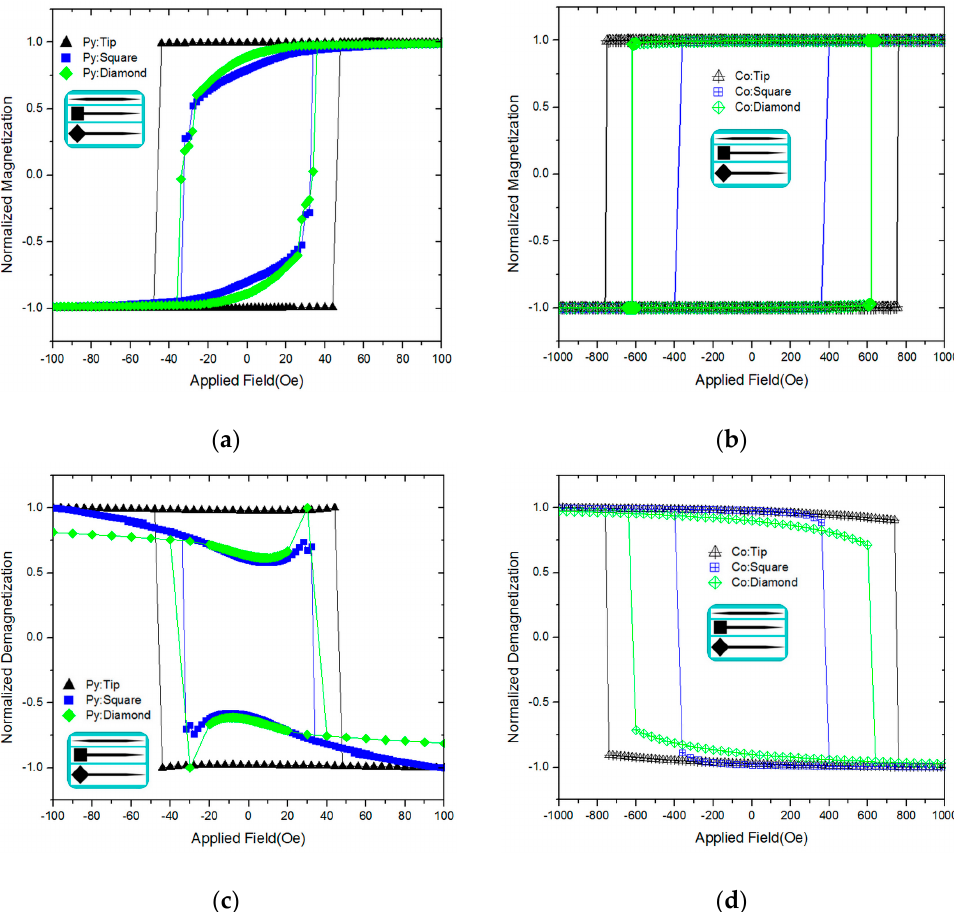
Figure 3. ( a ) The hysteresis loops of permalloy ( b ) the hysteresis loops of cobalt ( c ) the demagnetization loops of permalloy ( d ) the demagnetization loops of cobalt from the OOMMF micromagnetic simulations, which are shown for all of the shapes.